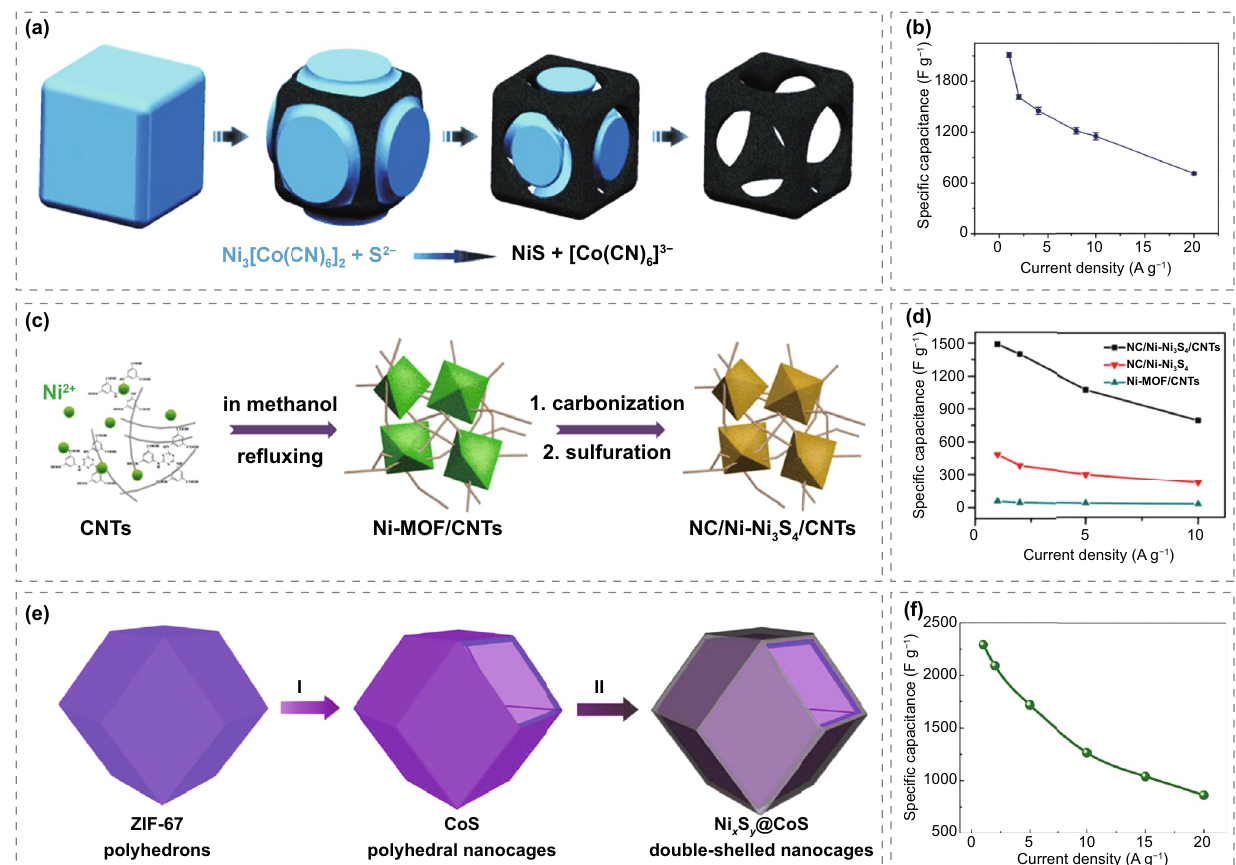
Fig. 12 a Diagram of NiS nanoframe formation process. b The specific capacitance was calculated from the discharge curve. Reprinted with permission from Ref. [150]. Copyright 2015 WILEY–VCH Verlag GmbH & Co. KGaA c Scheme of the synthesis of NC/Ni-Ni 3 S 4 /CNTs com- posite. d The specific capacitances at different current densities. Reprinted with permission from Ref. [151]. Copyright 2020 American Chemi- cal Society. e Schematic diagram of the formation of amorphous Ni x S y @CoS double-shelled nanocages. f Corresponding specific capacitance calculated from the discharge curves. Reprinted with permission from Ref. [152]. Copyright 2017 Elsevier